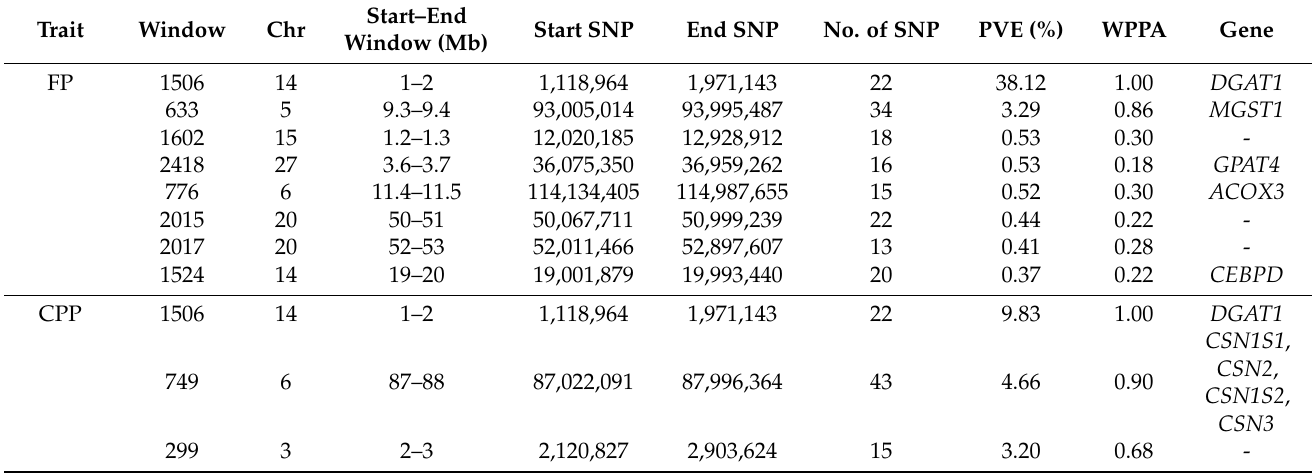
Table 6. The 1 Mb SNP windows surpass genome-wide significance level that is proportion of genetic variance (PVE) at 0.37% with their and window posterior probability of association (WPPA) for milk fat (FP) and crude protein (CPP) percentages, milk urea (MU) and efficiency of crude protein utilization